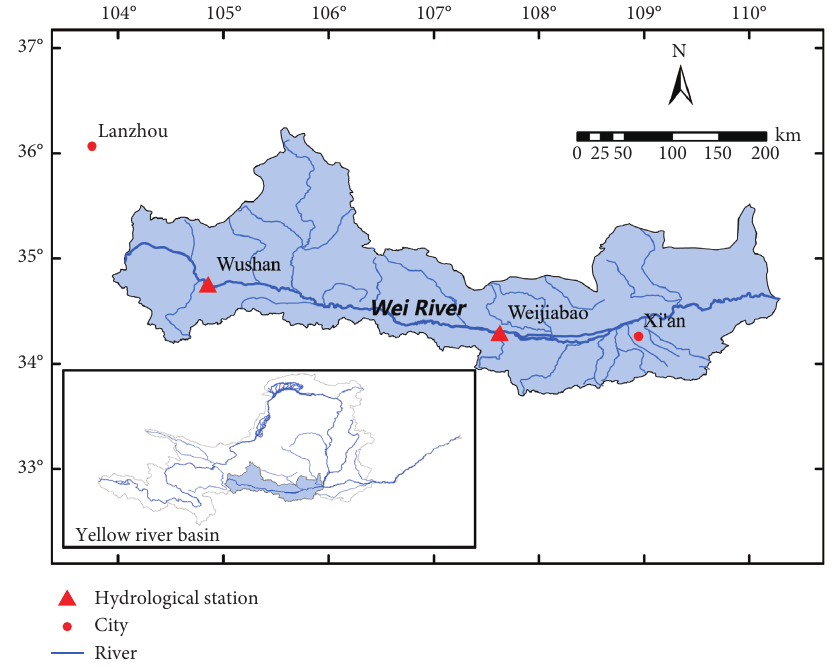
Figure 2: Study area and location of the two hydrological stations in the Wei River Basin, China.